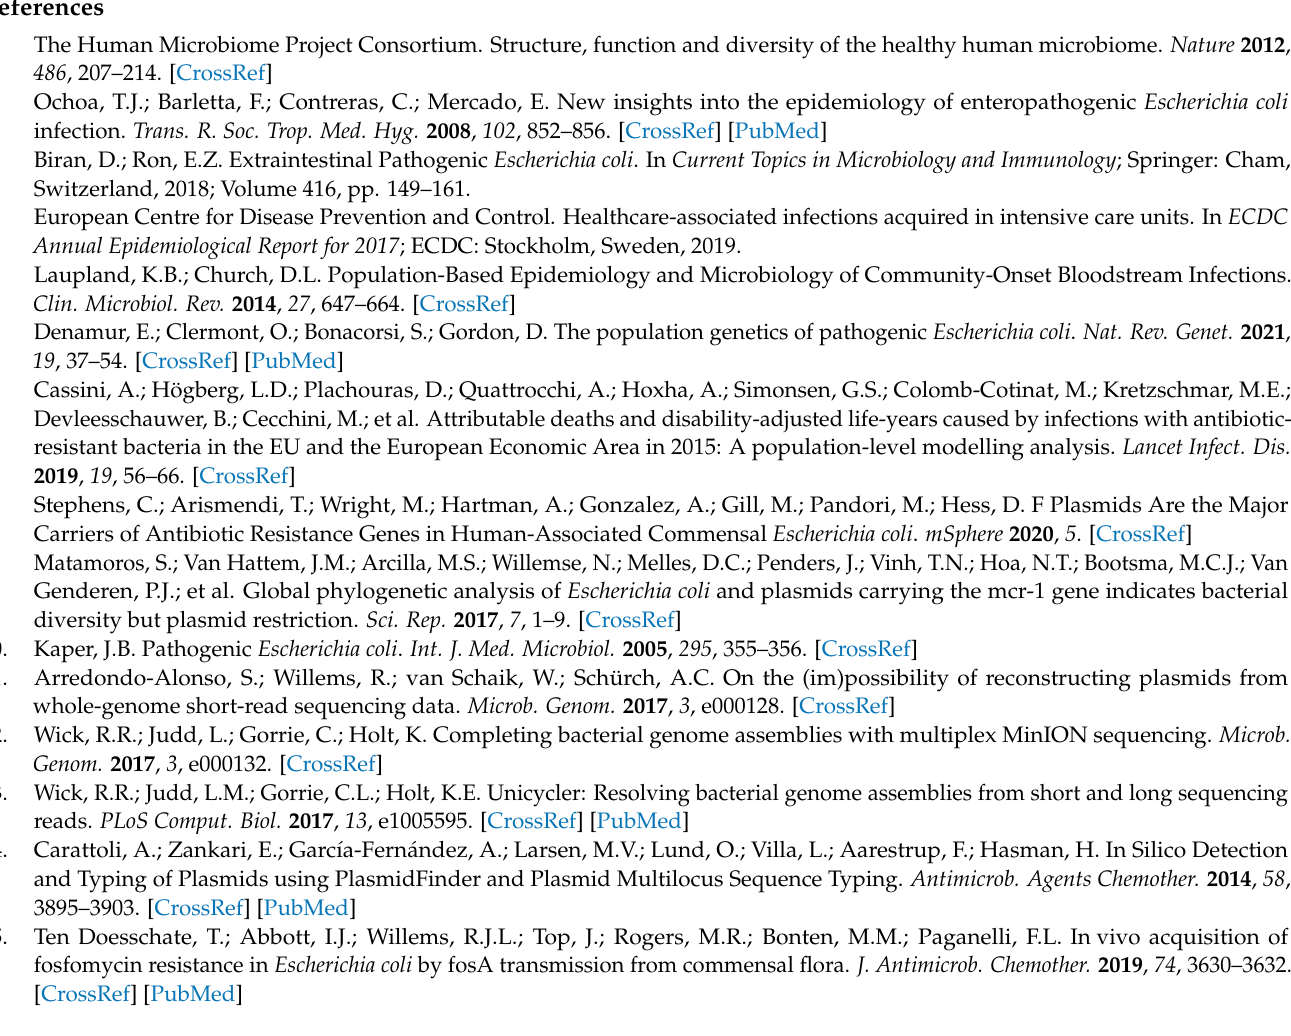
ESBL plasmids. Additionally, Supplementary Tables are also available. Table S1: Plasmid prediction tools summary, Table S2: Microreact metadata visualization, Table S3: Metadata of benchmark dataset, Table S4: QUAST alignment results, Table S5: Self-alignment results, Table S6: Reference plasmids